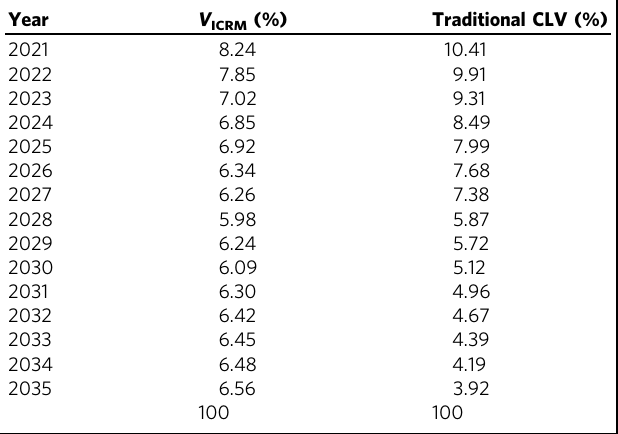
Table 6 Annual relative weight of the value of each model. Table 7 Results of the Scheirer – Ray – Hare test and Mood ’ s median test for the two